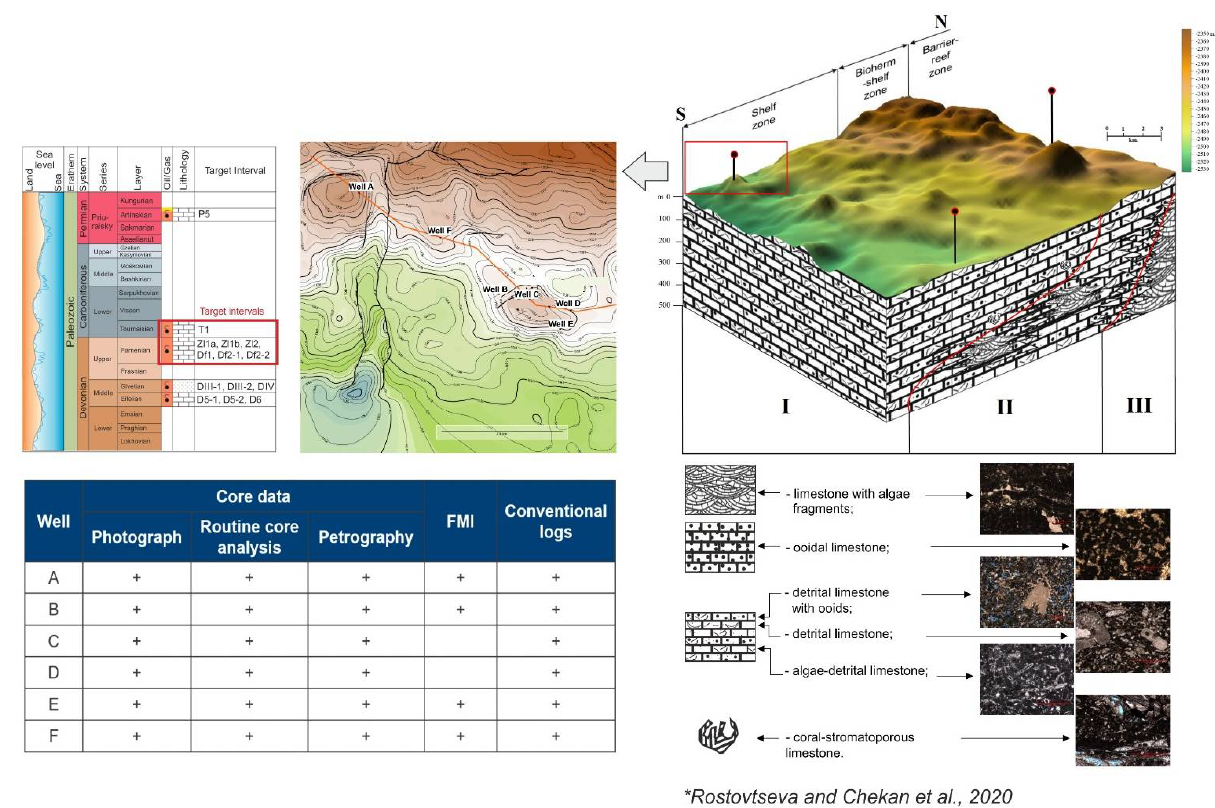
Figure 3. Geological background of the studied field. The conceptual model was previously created based on the limited number of drilled exploration wells. Wells with FMI data were not used in the conceptual model. During the late Devonian time, three facial zones were formed: I—shelf zone, II—bioherm zone, and III—barrier reef zone. It happened when the late Famennian barrier reef stopped migrating.